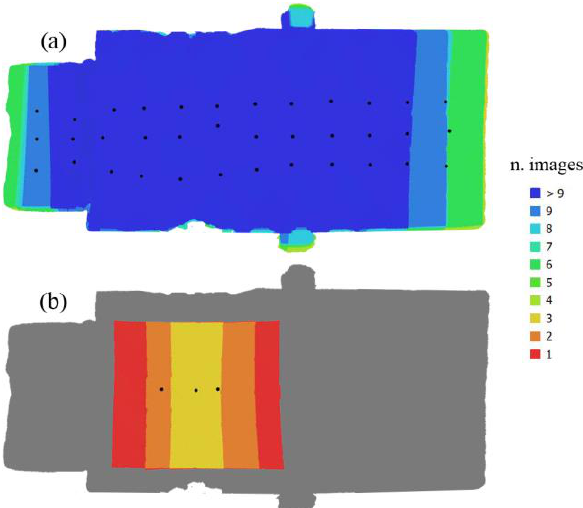
Figure 3. Image overlap scheme. (a) Acquisition of true colour dataset and (b) Acquisition of thermal